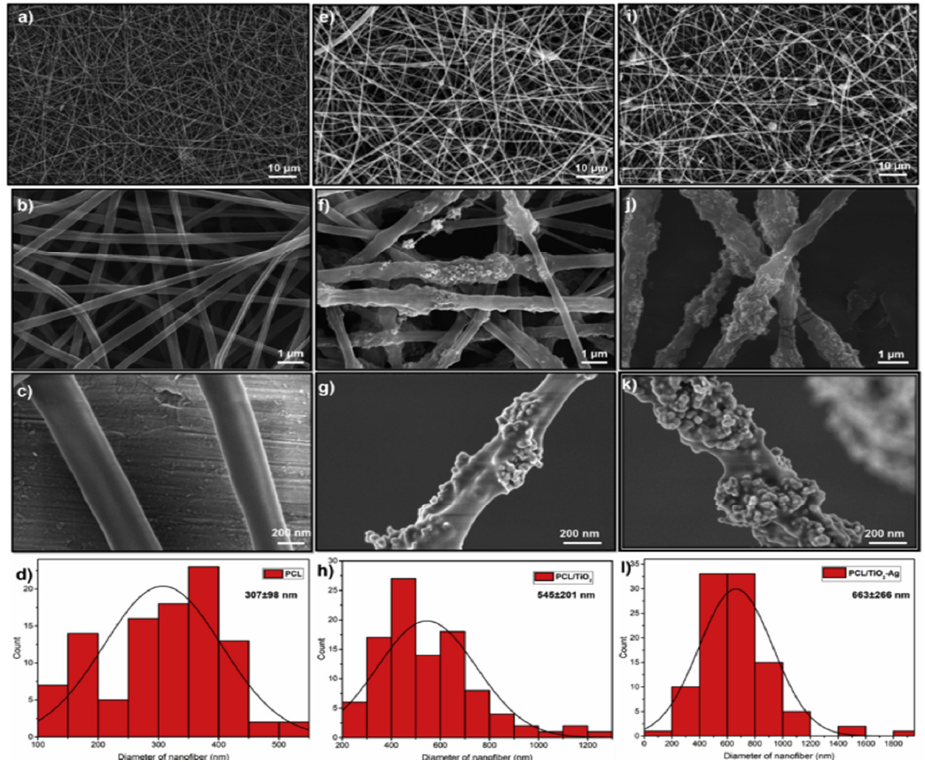
Figure 11. SEM images of ( a – c ) PCL, ( e – g ) PCL/TiO 2 , ( i – k ) PCL/TiO 2 -Ag NFs. Histogram presented the diameter distribution of ( d ) PCL, ( h ) PCL/TiO 2 , ( l ) PCL/TiO 2 -Ag NFs. Reprinted with permission of [46].